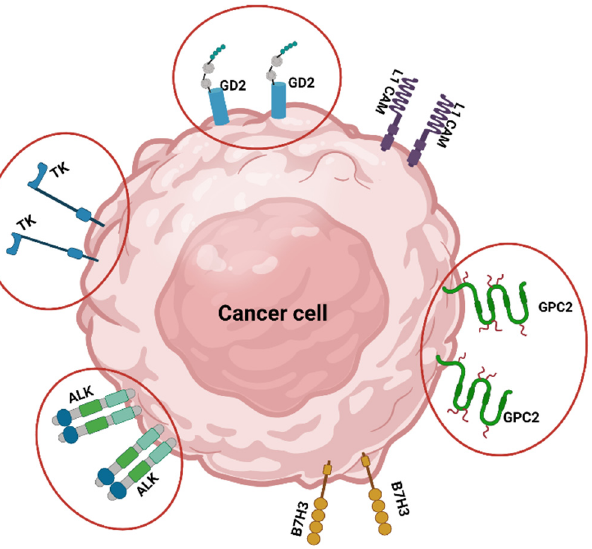
Figure 1. Molecular targets in Neuroblastoma. The image shows 6 different targets: tyrosine kinases (TK); GD2; L1 cell adhesion molecule (L1 CAM); glypican-2 (GPC2); B7H3, and anaplastic lymphoma kinase (ALK). Molecules highlighted in red discussed in paragraph 2.